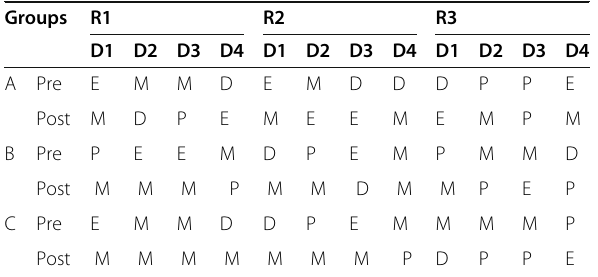
Table 4 The effect of MEPO on the estrous cycle of adult female Wistar rats Groups